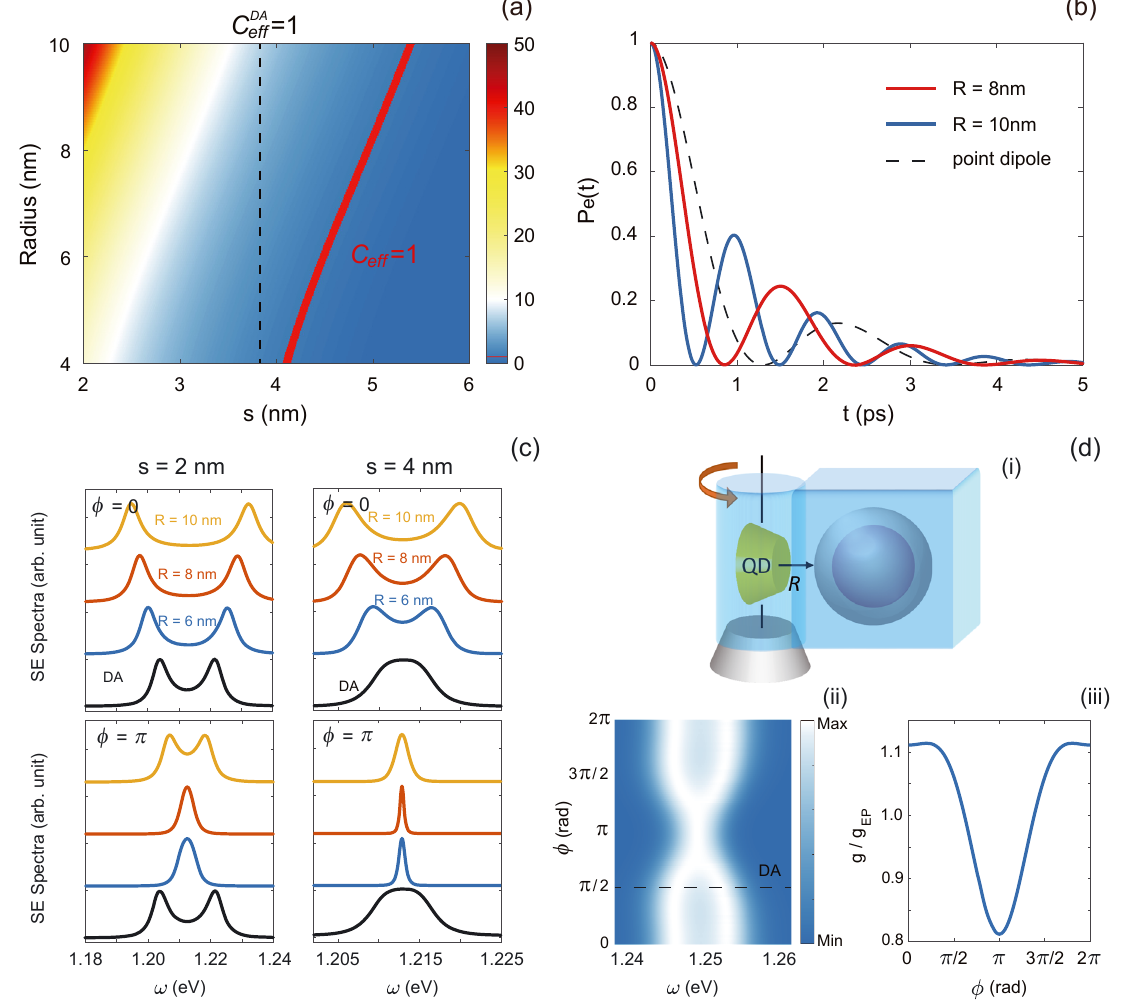
as the function of QD radius and s eff = 1 . c